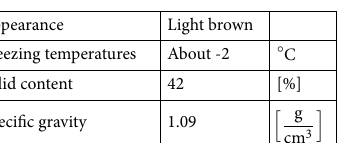
Table 4. Characteristics of superplasticizer additive.